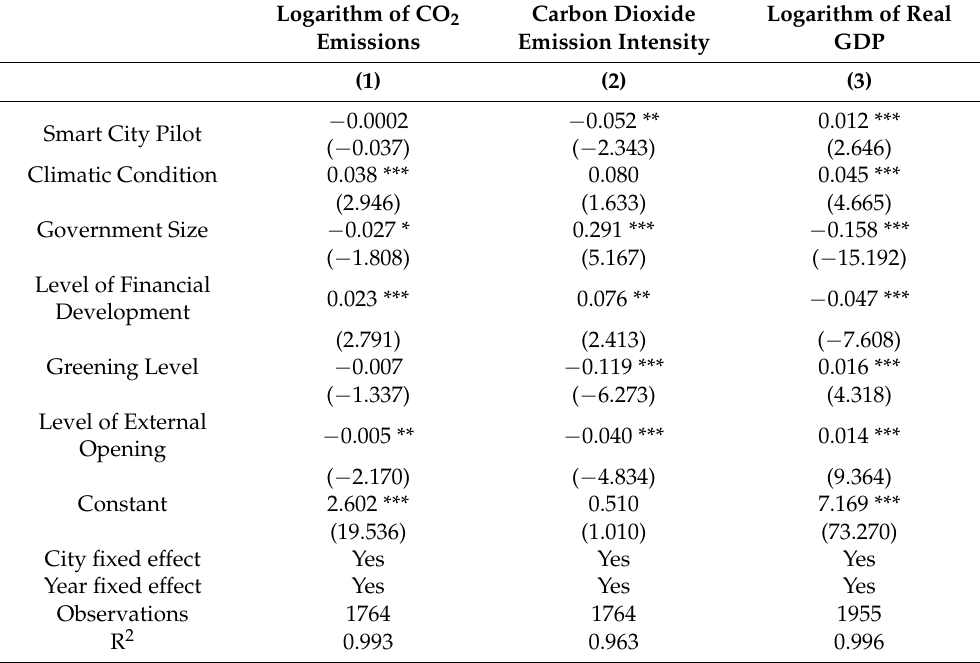
Table 7. Other benefits regression